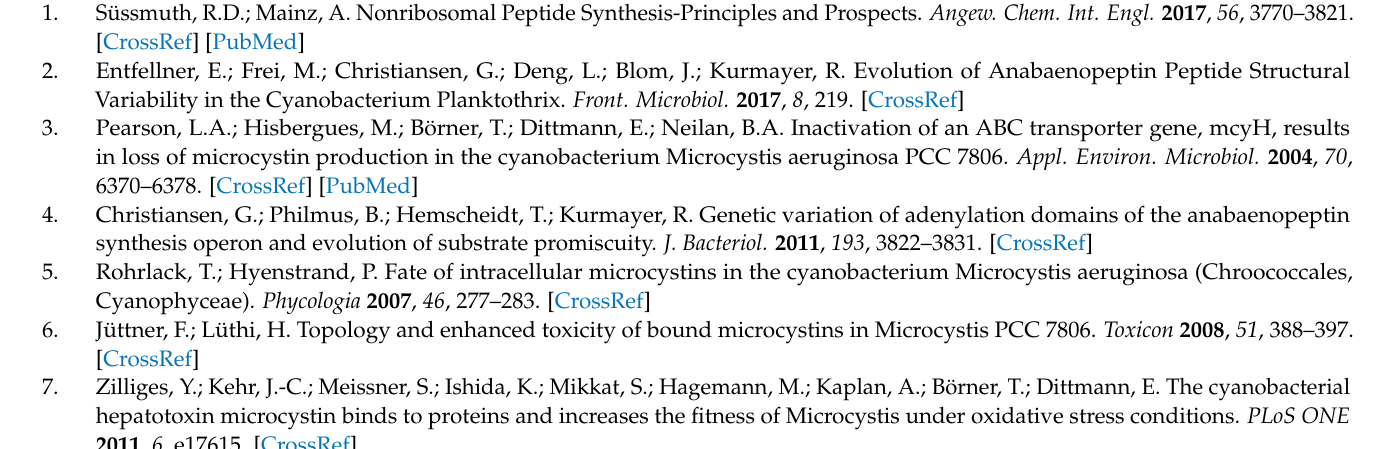
Figure S2: Confocal images of modified MCs ( M. aeruginosa ) or APs ( P. agardhii ) obtained from cells supplemented with Phe-Az. Figure S3: Confocal images of modified MCs ( M. aeruginosa ) or APs ( P. agardhii ) obtained from cells supplemented with Prop-Lys. Figure S4: Confocal images of modified MCs ( M. aeruginosa ) or APs ( P. agardhii ) obtained from cells in absence or presence supplemented AA Phe-Az, Prop-Lys and Prop-Tyr. Figure S5: M. aeruginosa LC-MS BPC and EIC chromatograms. Figure S6: Synechocystis PCC6803 LC-MS BPC and EIC chromatograms. Figure S7: P. agardhii No371/1 LC-MS BPC and EIC chromatograms. Figure S8: P. agardhii CYA126/8 WT LC-MS BPC and EIC chromatograms. Figure S9: P. agardhii CYA126/8 ∆ apnC LC-MS BPC and EIC chromatograms. Figure S10: P. agardhii CYA126/8 ∆ ociA LC-MS BPC and EIC chromatograms. Figure S11: P. agardhii CYA126/8 ∆ mvdC LC-MS BPC and EIC chromatograms. Figure S12: P. agardhii CYA126/8 ∆ mcyD LC-MS BPC and EIC chromatograms. Figure S13: Confocal images of non-modified MCs ( M. aeruginosa ) or APs ( P. agardhii ) and lipids. Figure S14: Confocal images of lipids from cells supplemented with Phe-Az. Figure S15: Confocal images of simultaneous labeling of Prop-Lys modified MCs ( M. aeruginosa ) or APs ( P. agardhii ) and lipids used for colocalization measurements.